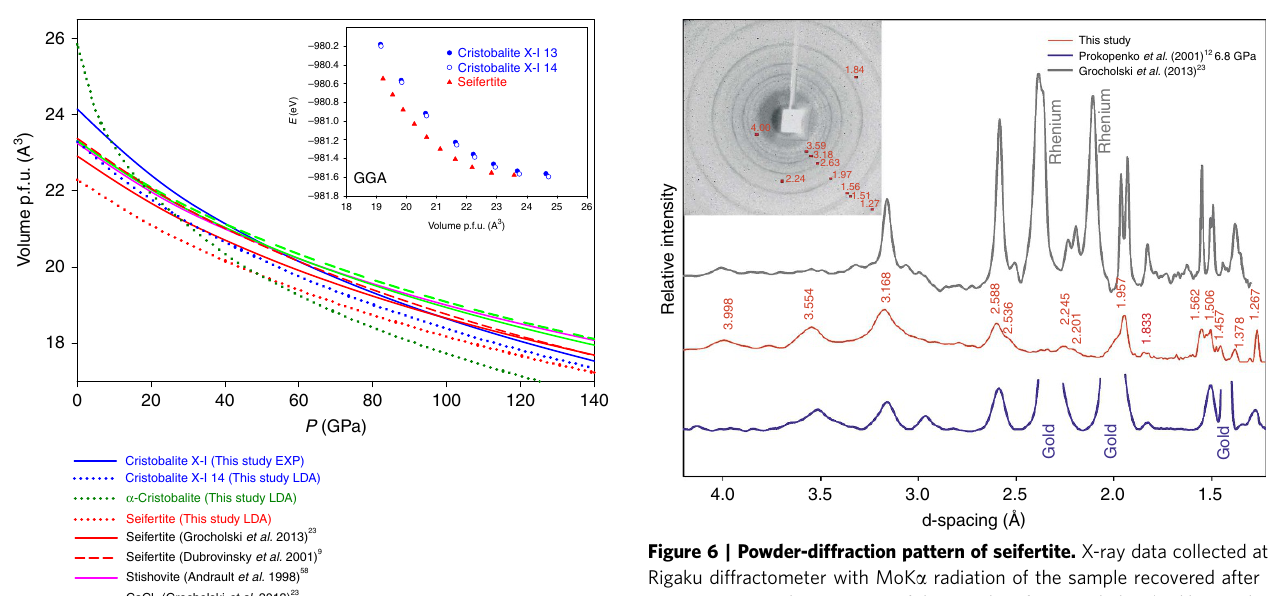
(FIB) foil extraction (see Sample recovery and preparation for TEM in Methods section). Both techniques showed similar